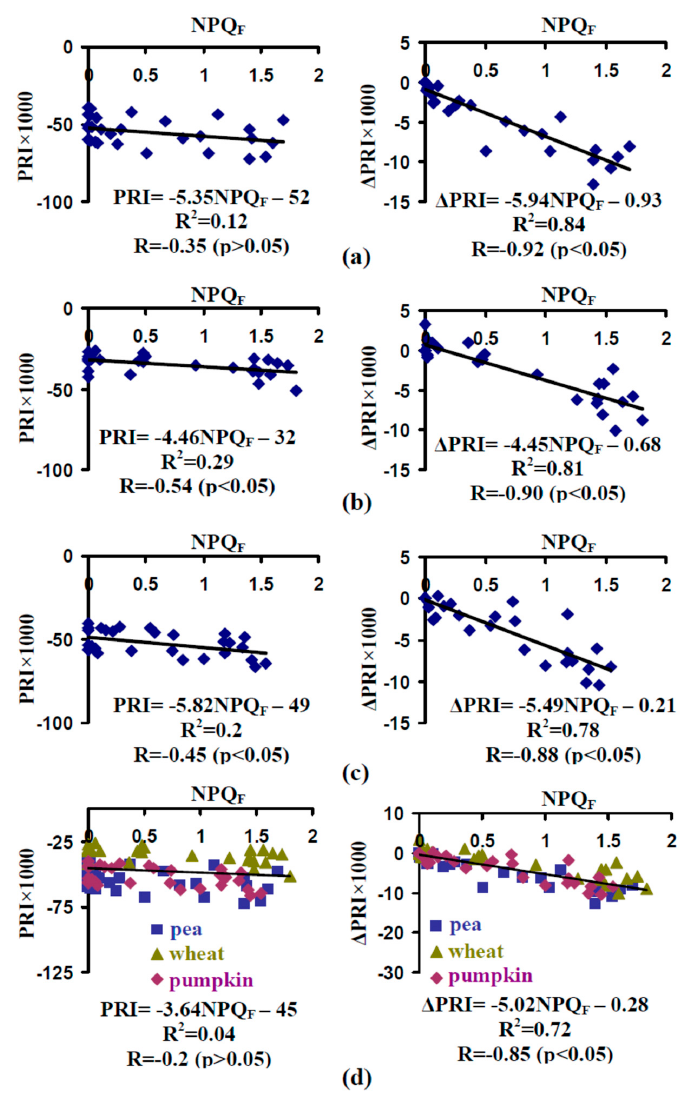
Figure 7. Dependences of the absolute value of the PRI and ∆ PRI on the energy-dependent component of NPQ F in pea ( n = 30) ( a ), wheat ( n = 30) ( b ), pumpkin ( n = 30) ( c ), as well as in all plants of investigated species ( d ) ( n = 90). The duration of illumination for each intensity of AL (wavelength 630 nm) was 5 min, and the subsequent dark relaxation was 2 min. NPQ F was calculated as FF FF − , where F m ’ 0 and F m ’ S are F m ’ (the current maximum yield of fluorescence) before the termination of AL illumination and for 2 min after that, respectively. PRI was calculated as RR +− 570531 . R 531(570) was calculated as R 531(570) Averaged – R 531(570) BG . R 531(570) BG is the absolute intensity of the reflected light at 531 (570) nm before the GYL pulse and R 531(570) Averaged is the averaging of the absolute intensities of the reflected light at 531 (570) nm during the GYL pulse. Δ PRI was calculated as the difference between PRI after 5 min of illumination by AL and the initial PRI (without AL). Experimental plots include values, which were measured at different light intensities and under dark conditions. R 2 and R are the determination and correlation coefficients, respectively.